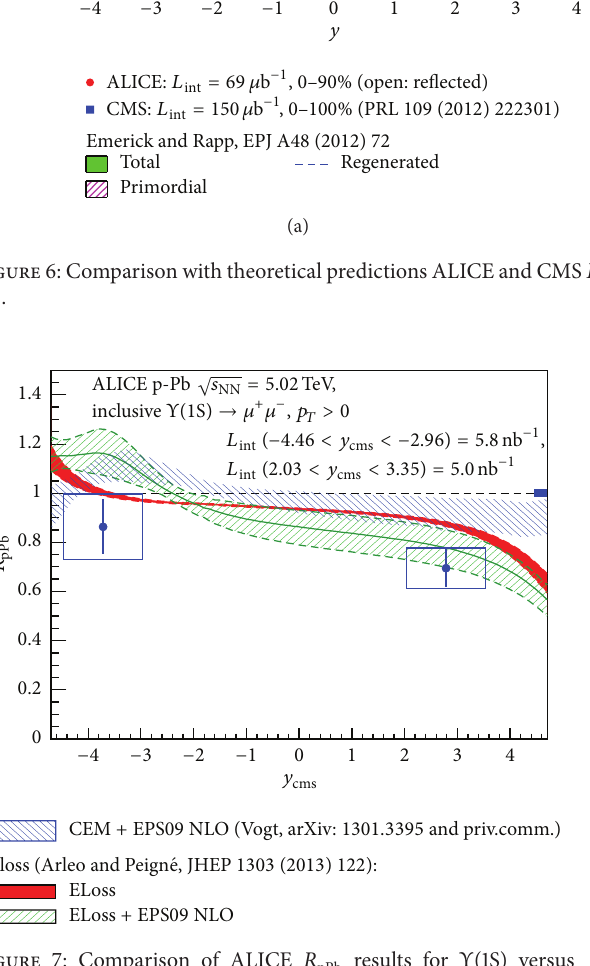
Figure 7: Comparison of ALICE 𝑅 pPb results for Υ (1S) versus rapidity with theoretical